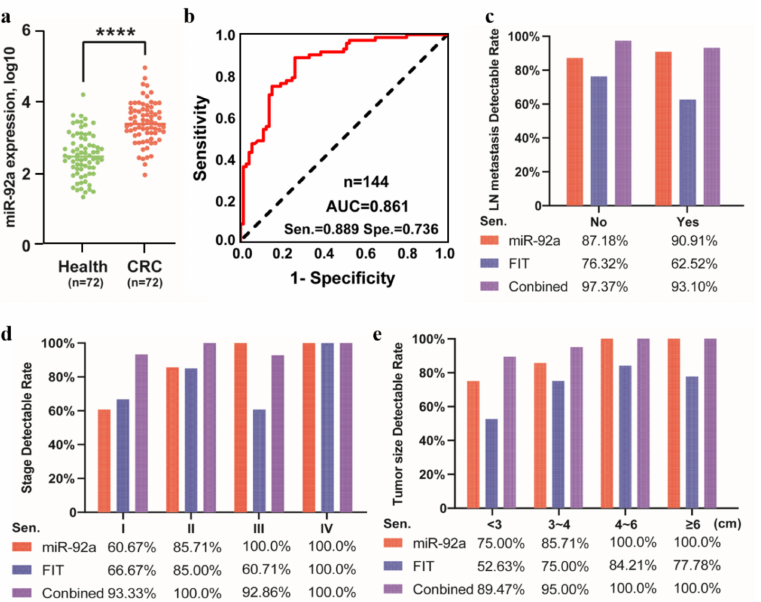
Figure 3. Independent stool-based data for recruited independent patients. ( a ) Comparison of levels of miR-92a from CRC patients and health controls; ( b ) ROC analysis using miR-92 to discriminate CRC; ( c – e ) The detection rate of miR-92a compared across CRC lymph node metastasis, stage, and tumor size, respectively. **** p <